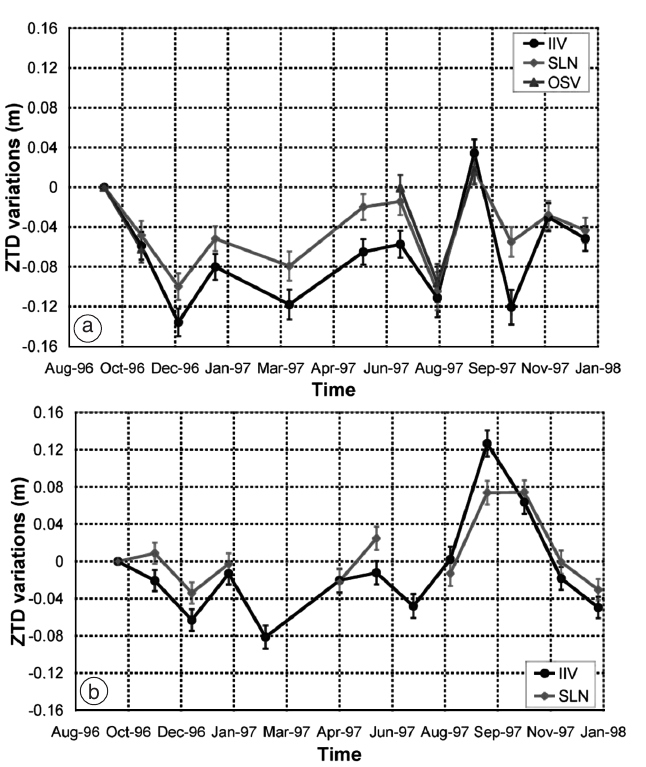
Fig. 4a,b. Variations of ZTD for the ascending (at 21:16) (a) and descending (at 09:41) (b) ERS-2 passes over Mt. Etna with respect to a reference time, that is conventionally assumed as the session carried out in a) 25/09/1996 and in b) 02/10/1996. The error bars are the errors on the variations of